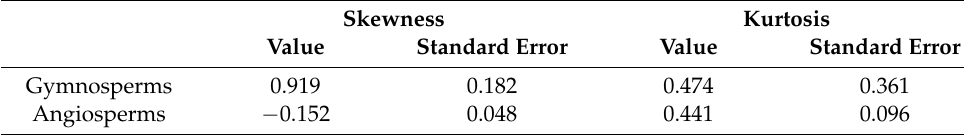
Table 2. Skewness and kurtosis of gymnosperm and angiosperm seed